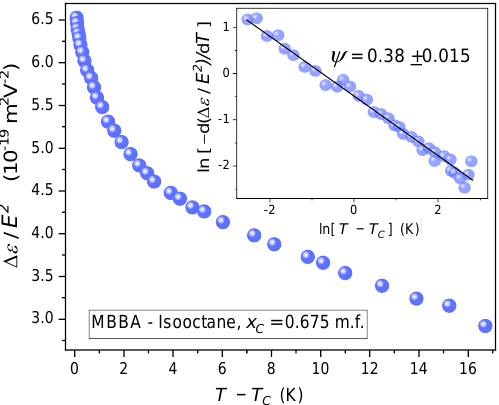
Figure 11. NDE pretransitional changes on approaching the critical consolute point in MBBA— Isooctane mixture for the concentration related to the top of the L-L coexistence curve shown in Figure 1. The inset validates the portrayal via the ‘critical’ Equation (8), with the exponent ψ = 0.380. It is related to the transformation of data based on Equation (9), which allows the determination of the critical contribution without a biasing impact of the non-critical background effect. In binary mixtures of limited miscibility, the total registered NDE is composed of the critical effect and the non-critical, background ‘molecular’ contribution, namely [126,127]: